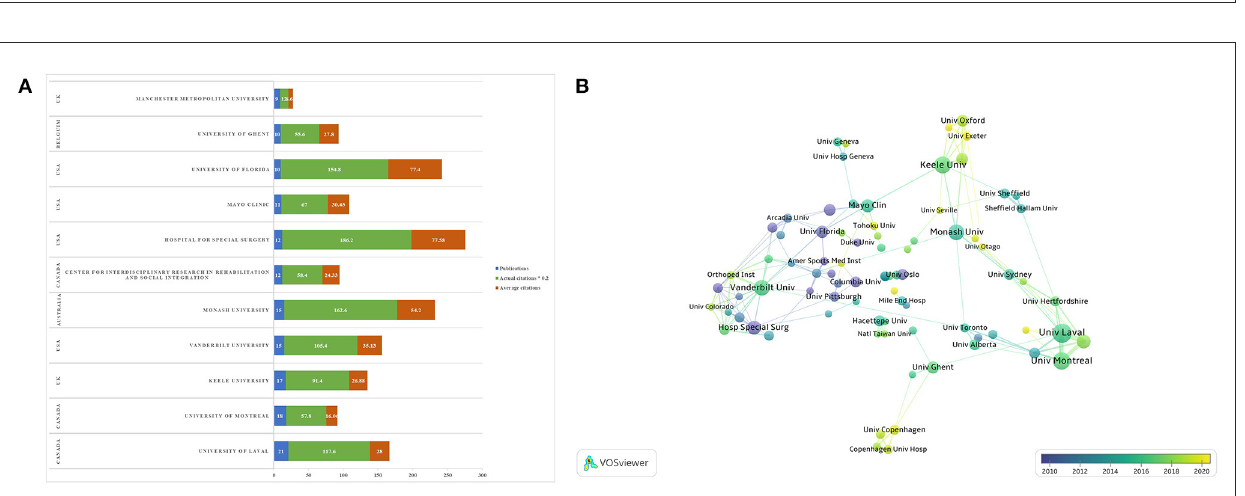
University of Montreal (Figure 6B). Additionally, there were two authors from the University of Monash, and the others were from various institutions around the world. We selected 70 items